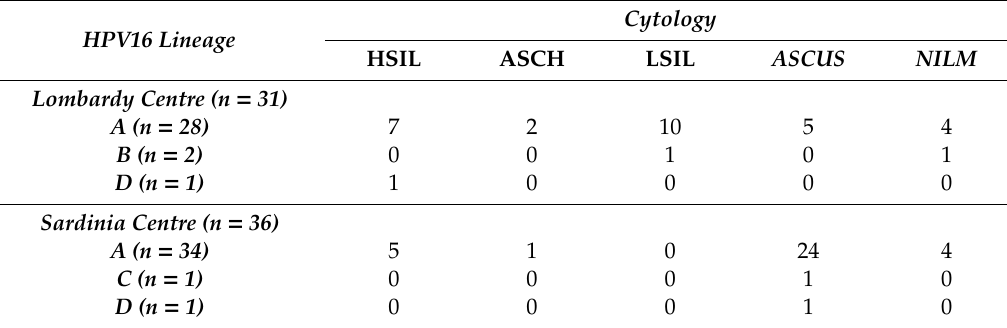
Table 2. HPV16 lineage distribution by cytological